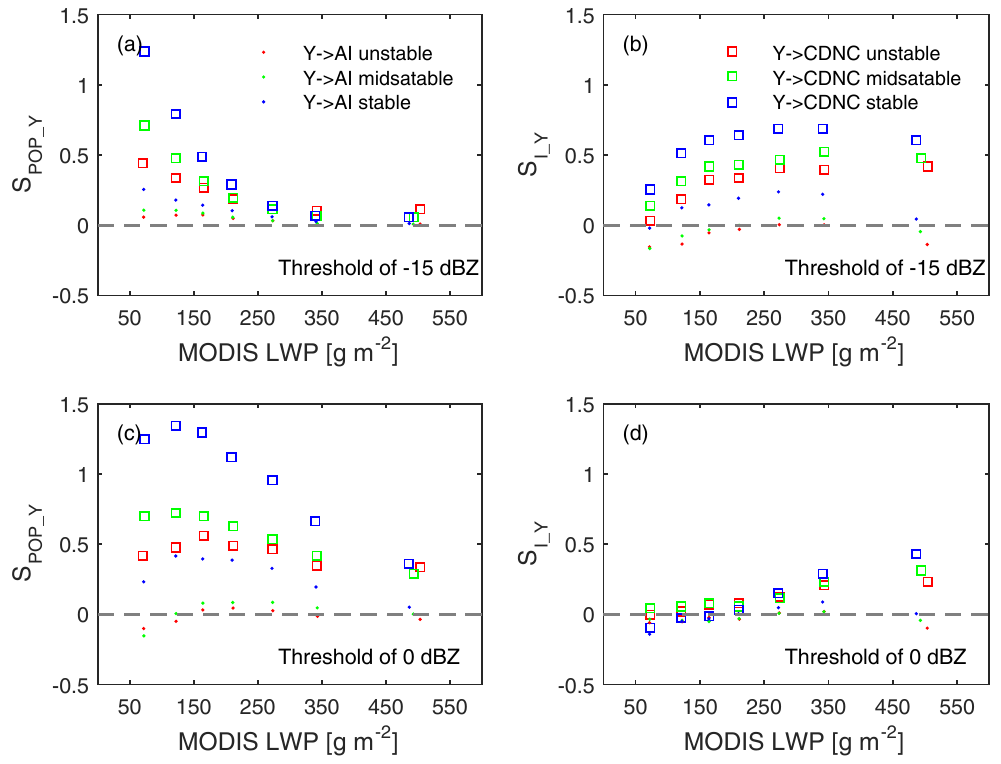
Figure 11. (a, c) S POP_Y and (b, d) S I_Y as a function of MODIS LWP. The subscript Y denotes different aerosol proxies corresponding to AI (point) and CDNC (square). Blue, red, and green symbols stand for stable, unstable, and midstable regimes, respectively. Rain data come from 2B-GEOPROF. The top panels are for results based on the rain threshold of − 15dBZ and the bottom panels are based on the rain threshold of